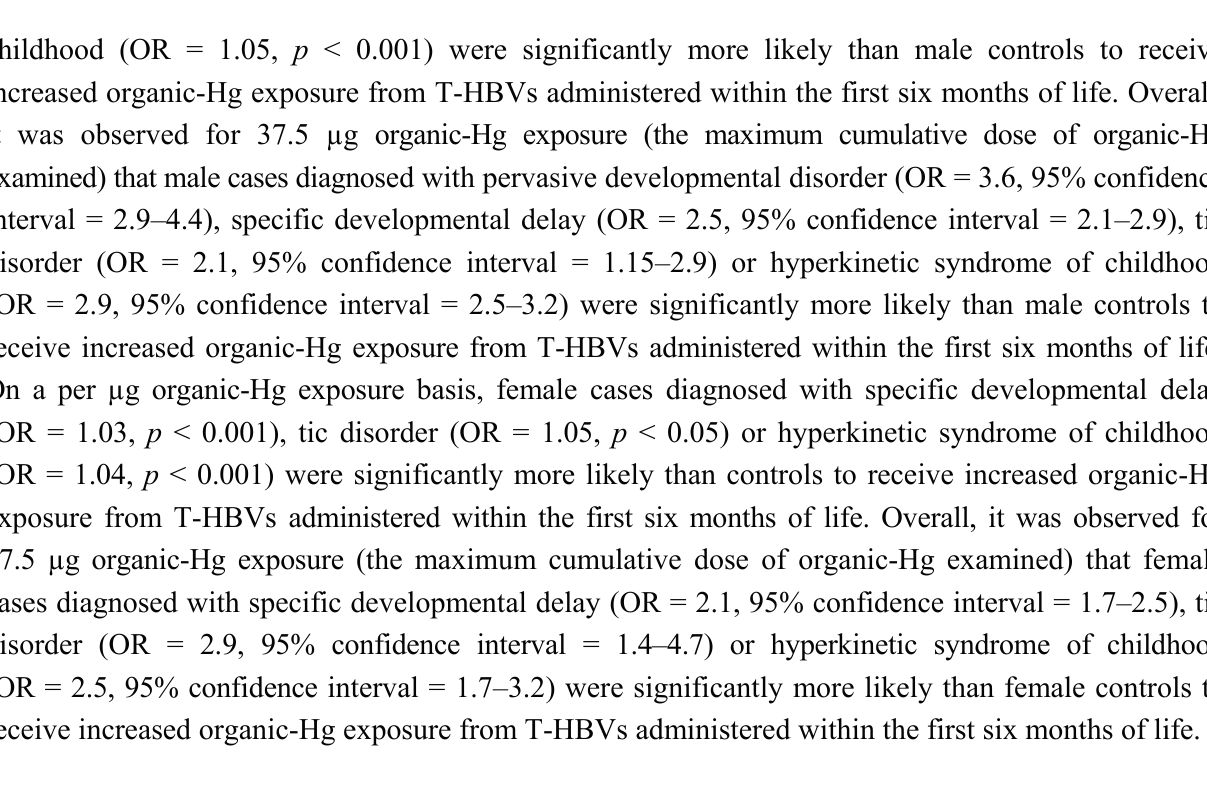
Table 3. A summary of exposure to organic-Hg from thimerosal-containing hepatitis B vaccine administration within the first six months of life when separating male and female ND cases and